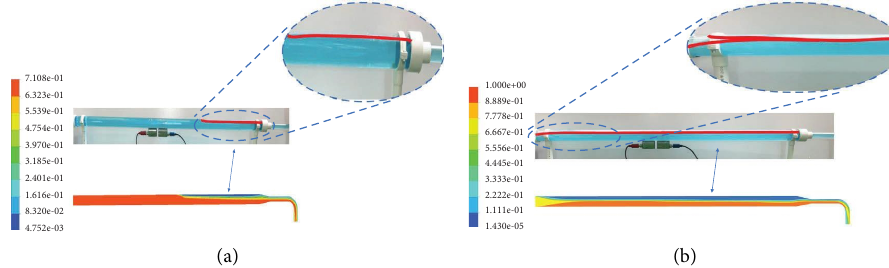
Figure 11: Diagram of the distributions of the fow feld. (a) Without bubbles. (b) With bubbles (gas volume fraction �